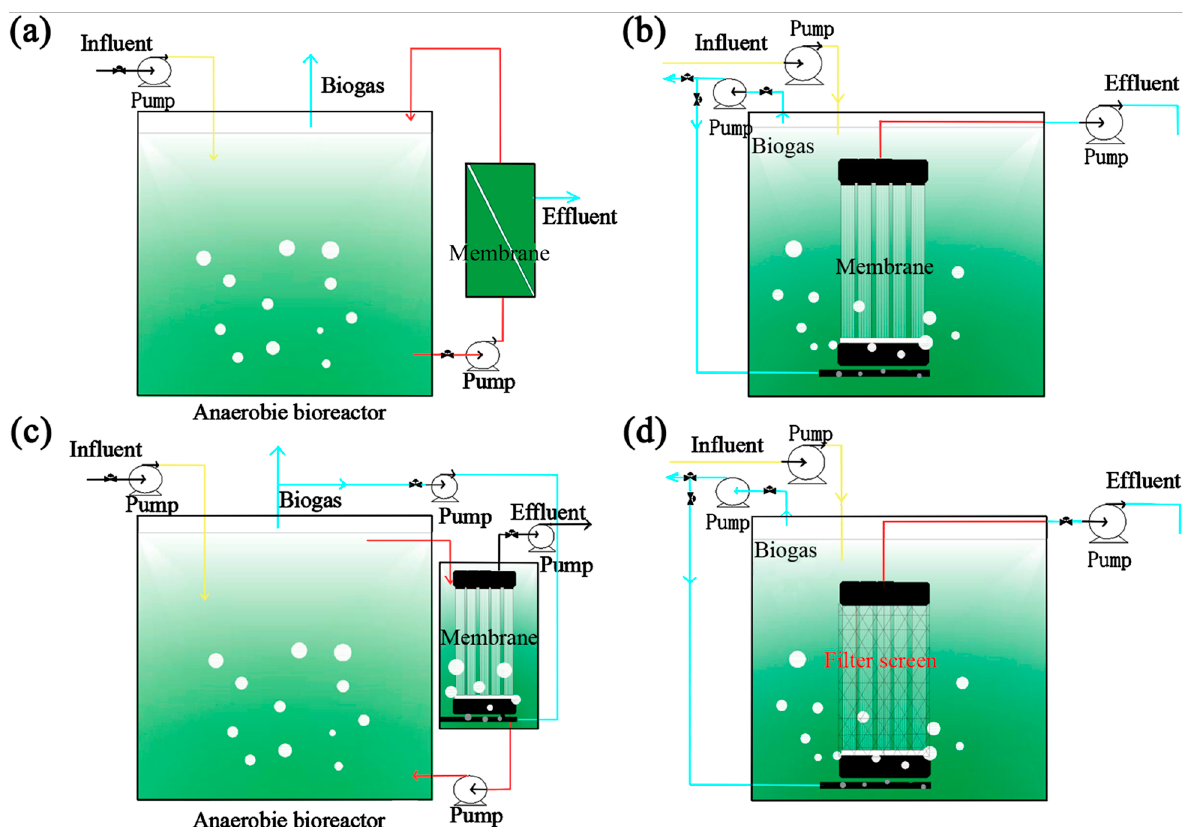
Figure 1. Fundamental schematics of conventional AnMBR: ( a ) SS-AnMBR, ( b ) S-AnMBR, ( c ) ES- AnMBR, and ( d ) AnDMBR. (Source: [112]; copyright permission received on 15 February 2023, from Elsevier).